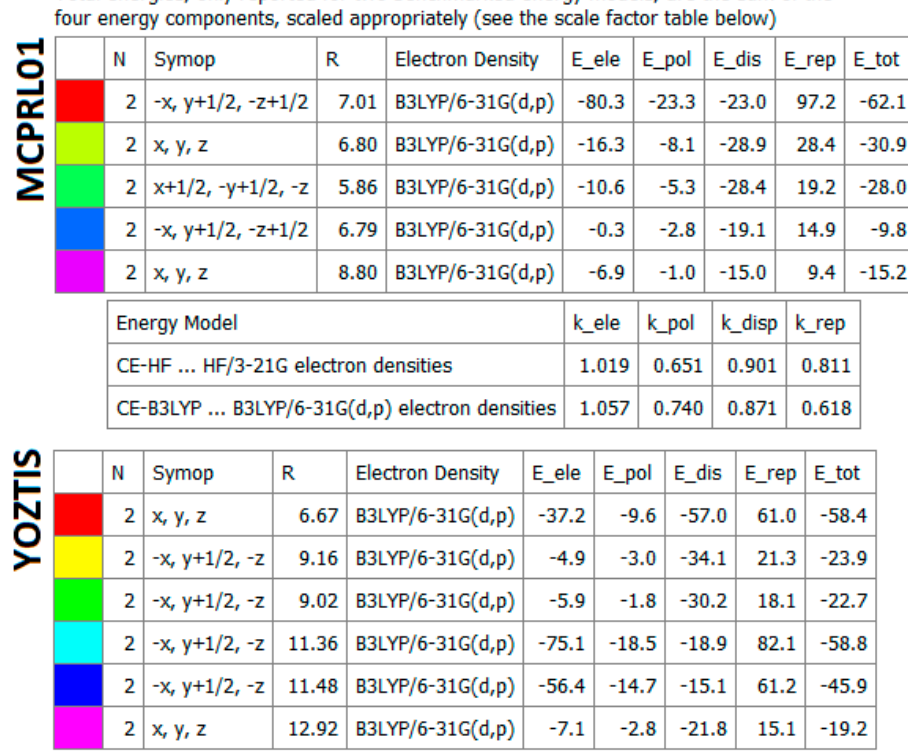
Figure 22. Interaction energies of the molecular pairs related to energy frameworks of captopril, on the left and captopril disulfide, on the right (scale factors for benchmarked energy models).